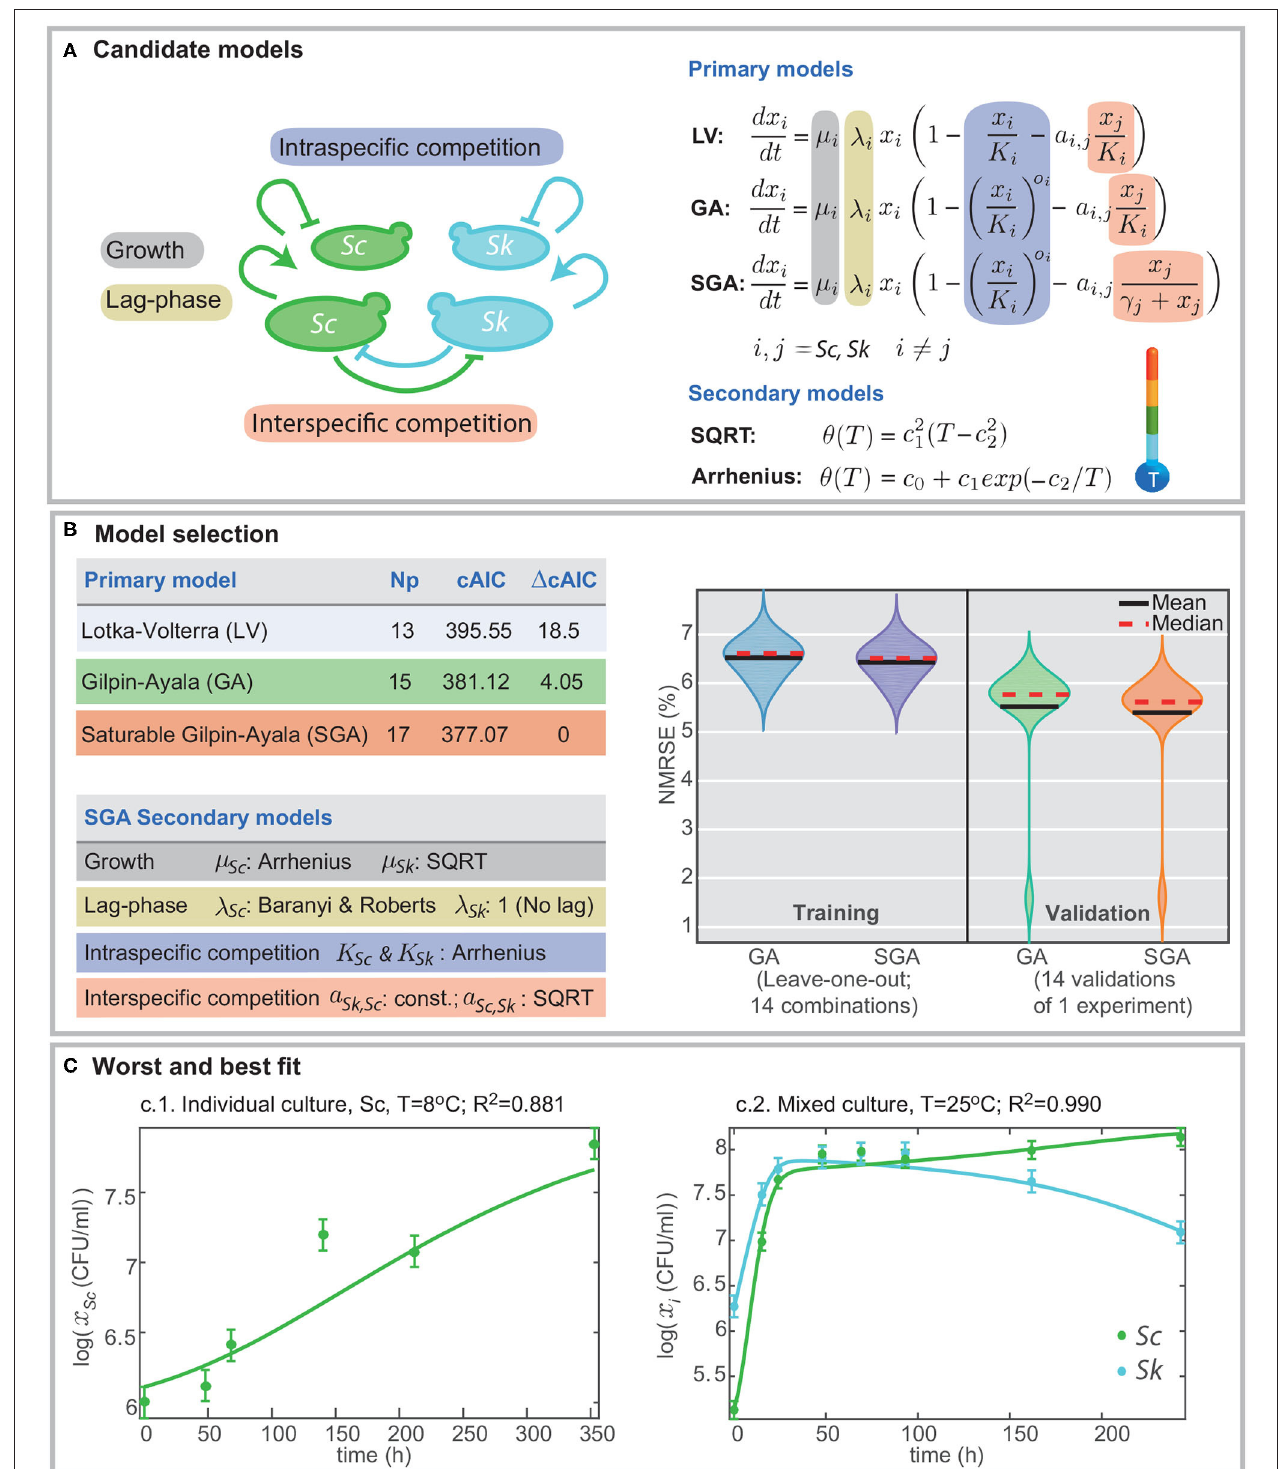
FIGURE 1 | Formulation of candidate models and model selection. (A) presents the different mechanisms included in the models, namely, growth, lag-phase, intra- and interspecific competition. Different definitions for intra- and interspecific competition result in different candidate models: Lotka-Volterra (LV), Gilpin-Ayala (GA), and Gilpin-Ayala with saturable competition (SGA). (B) presents the comparison of the best-fitted models. SGA is the best model; its fit to the multi-experiment data set results in better cAIC and the minimum training and validation errors in cross-validation. (C) shows the worst and best fit to the data for the multi-experiment model